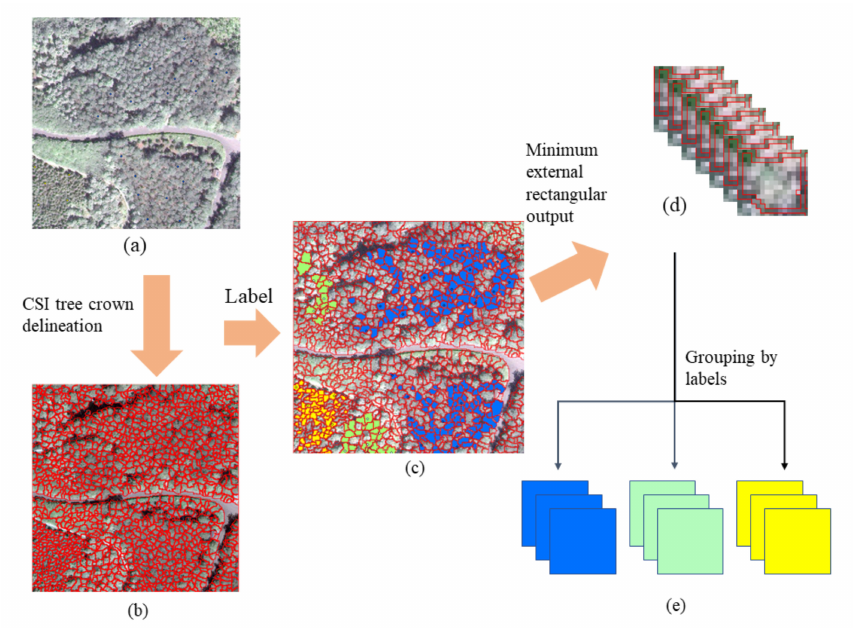
Figure 5. Schematic diagram of the training dataset construction. ( a ) Image of training sample collection region, ( b ) crown slices from imagery (CSI) algorithm-generated individual tree crown (ITC) map, ( c ) tree species labeled, ( d ) ITC slice images, ( e ) ITC training dataset. Data